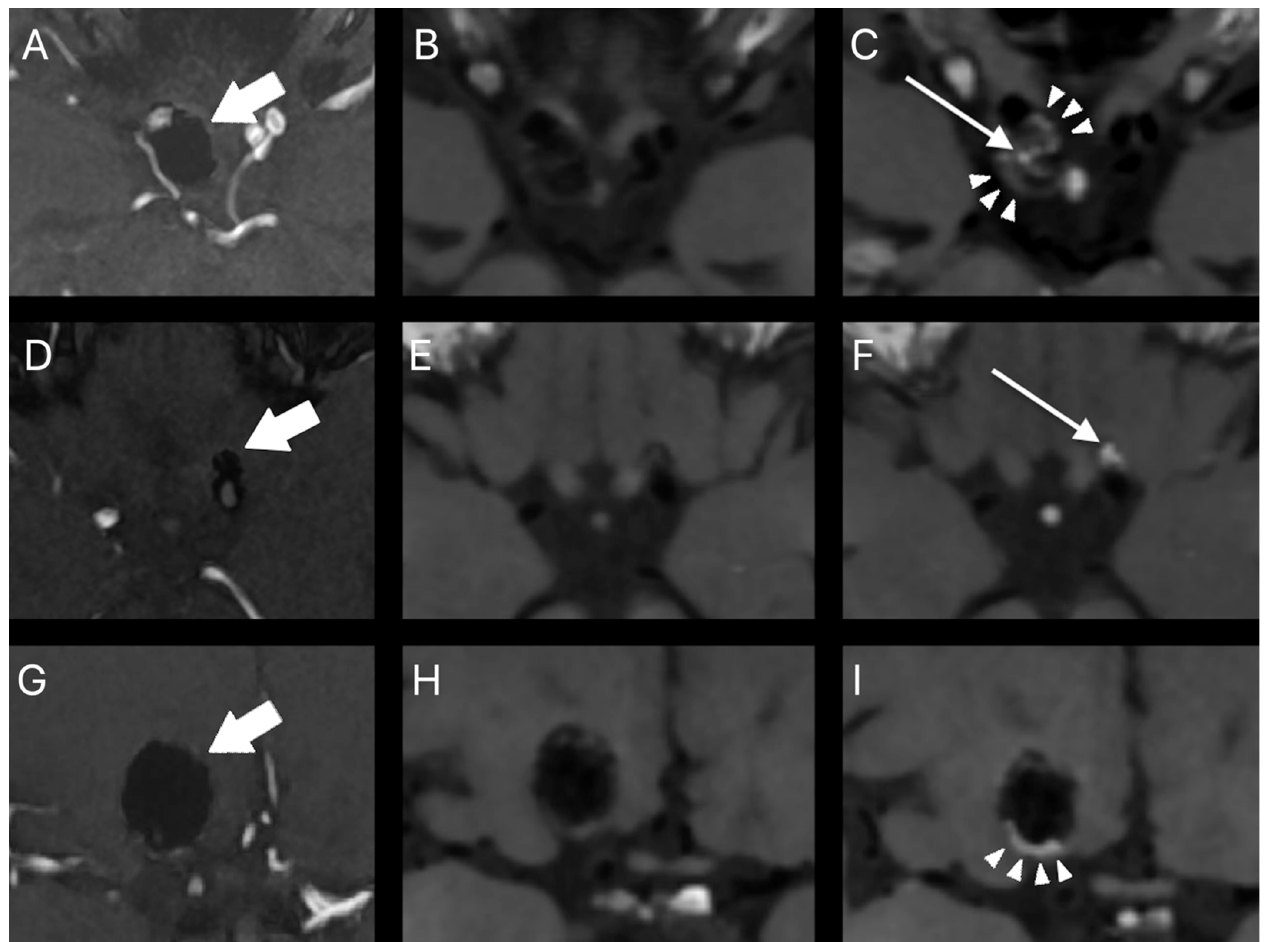
Figure 2. Representative cases of post-procedural aneurysm contrast enhancement on HR-VW MRI. Follow-up TOF MRA ( A , D , G ) and corresponding precontrast ( B , E , H ) and postcontrast ( C , F , I ) HR- VR MRI. Right internal carotid artery aneurysm treated with stent-assisted coiling (thick arrow) ( A – C ). There is no residual flow in the aneurysm cavity. Postcontrast HR-VW MRI shows contrast enhancement at the aneurysm periphery (arrowheads) as well as in the aneurysm cavity (thin arrow). Left internal carotid artery aneurysm treated with stent-assisted coiling (thick arrow) ( D – F ). Follow-up TOF MRA shows complete aneurysm occlusion. Postcontrast HR-VW MRI demonstrates intense contrast enhancement in the aneurysm cavity (thin arrow) with no contrast enhancement at the aneurysm periphery. Right internal carotid artery aneurysm treated with stent-assisted coiling (thick arrow) ( G – I ). The aneurysm is completely occluded. There is a thin rim of contrast enhancement at the aneurysm periphery (arrowheads) on postcontrast HR-VW MRI. No contrast enhancement in the aneurysm cavity is visible. Table 3. Post-procedural aneurysm contrast enhancement and aneurysm occlusion grade.